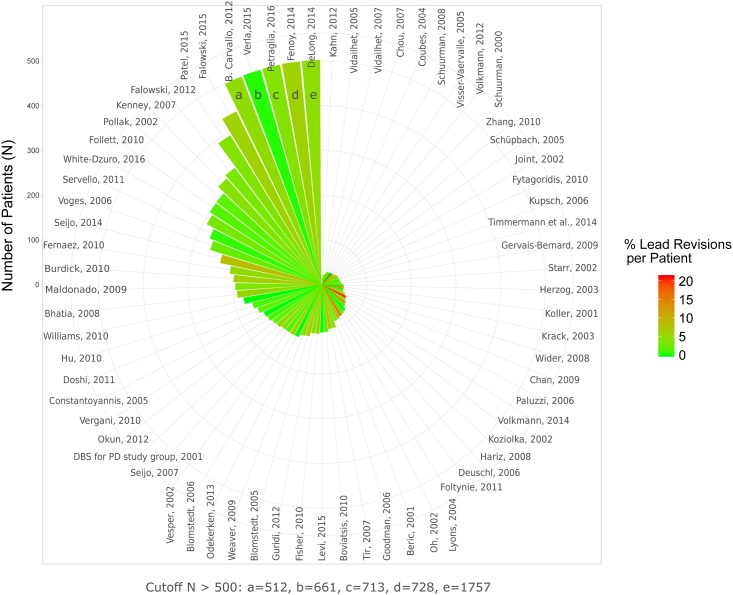
Percent lead revision per patient.The rate of AEs is color-coded. The number of patients that have been included in respective studies are indicated by the height of the wedges (cutoff value 500 patients).